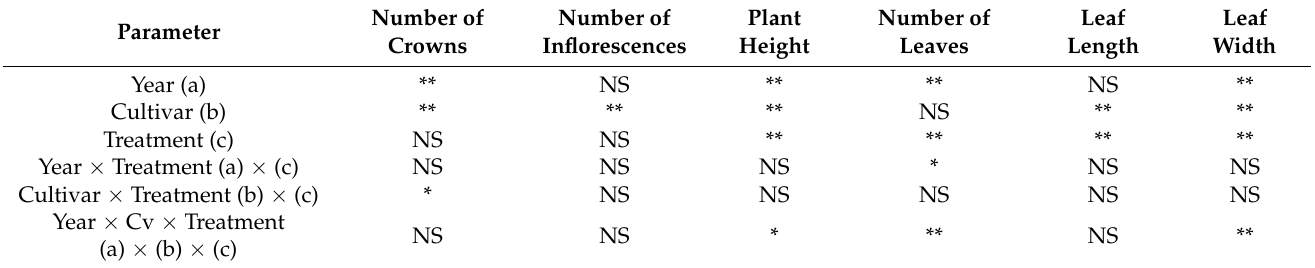
Table 5. Three-way analysis of variance (ANOVA) for the growth parameters ** = significant interac- tion with p < 0.01; * = significant interaction with p < 0.05; NS = not significant